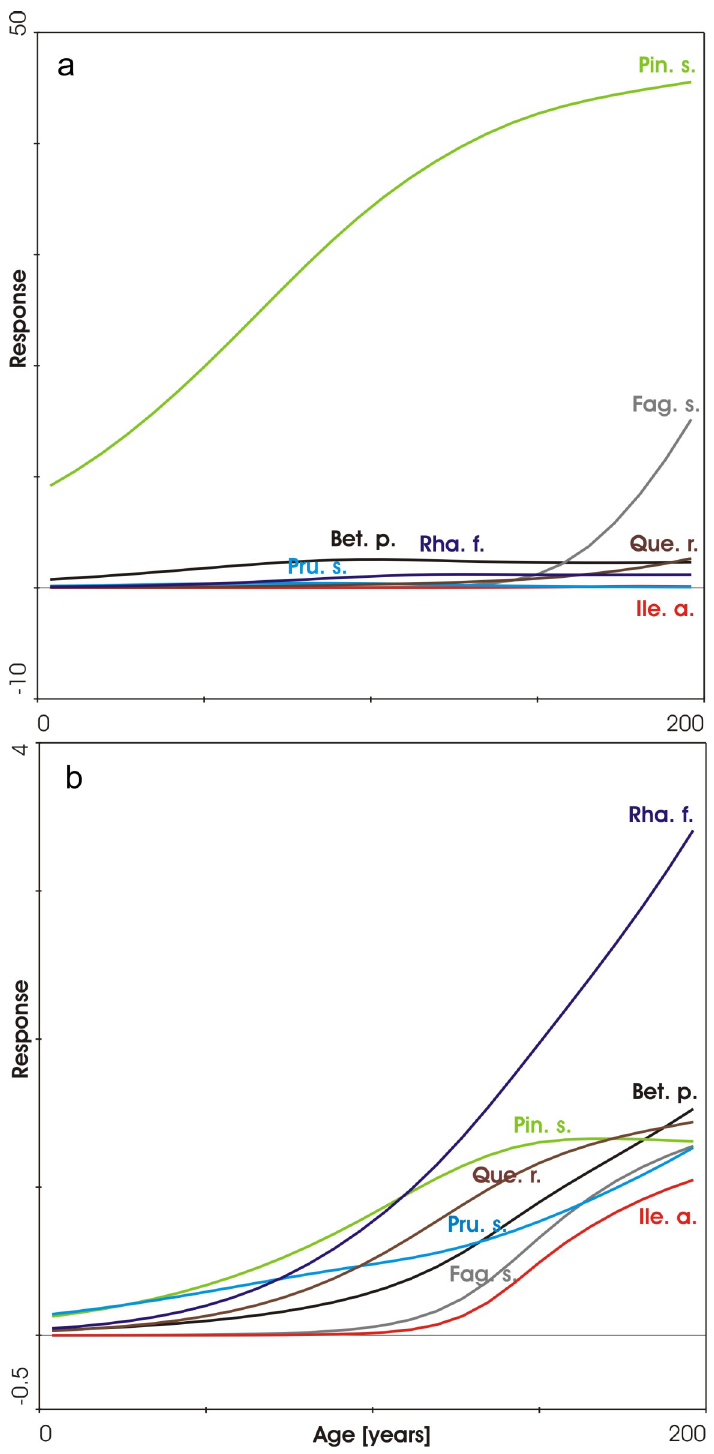
Fig 6. Response curves of woody species in the combined tree and shrub layer (a; up) and for woody species in the herb layer (b; down). Percentage cover values estimated in 100 m 2 plots were used as a response variable and the Poisson distribution was set using a GAM model. Names of species are abbreviated as follows: Bet. p.– Betula pendula ; Fag. s.– Fagus sylvatica ; Ile. a.– Ilex aquifolium ; Pin. s.– Pinus sylvestris ; Pru. s.– Prunus serotina ; Que. r.– Quercus robur ; Rha. f.– Rhamnus frangula